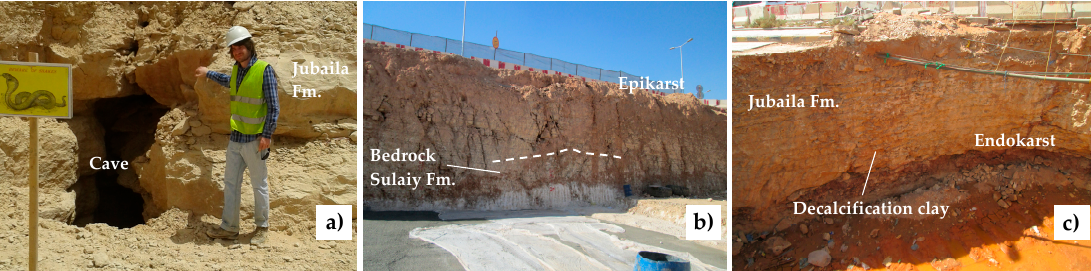
Figure 1. Different karst features found during the construction of the Riyadh Metro Line 3: ( a ) cave in Jubaila Fm. at the West Depot; ( b ) epikarst in Sulaiy Fm. at an open excavation and ( c ) endokarst following an interbedded dolomite layer in Jubaila Formation at the western end of Line 3 (RDA-